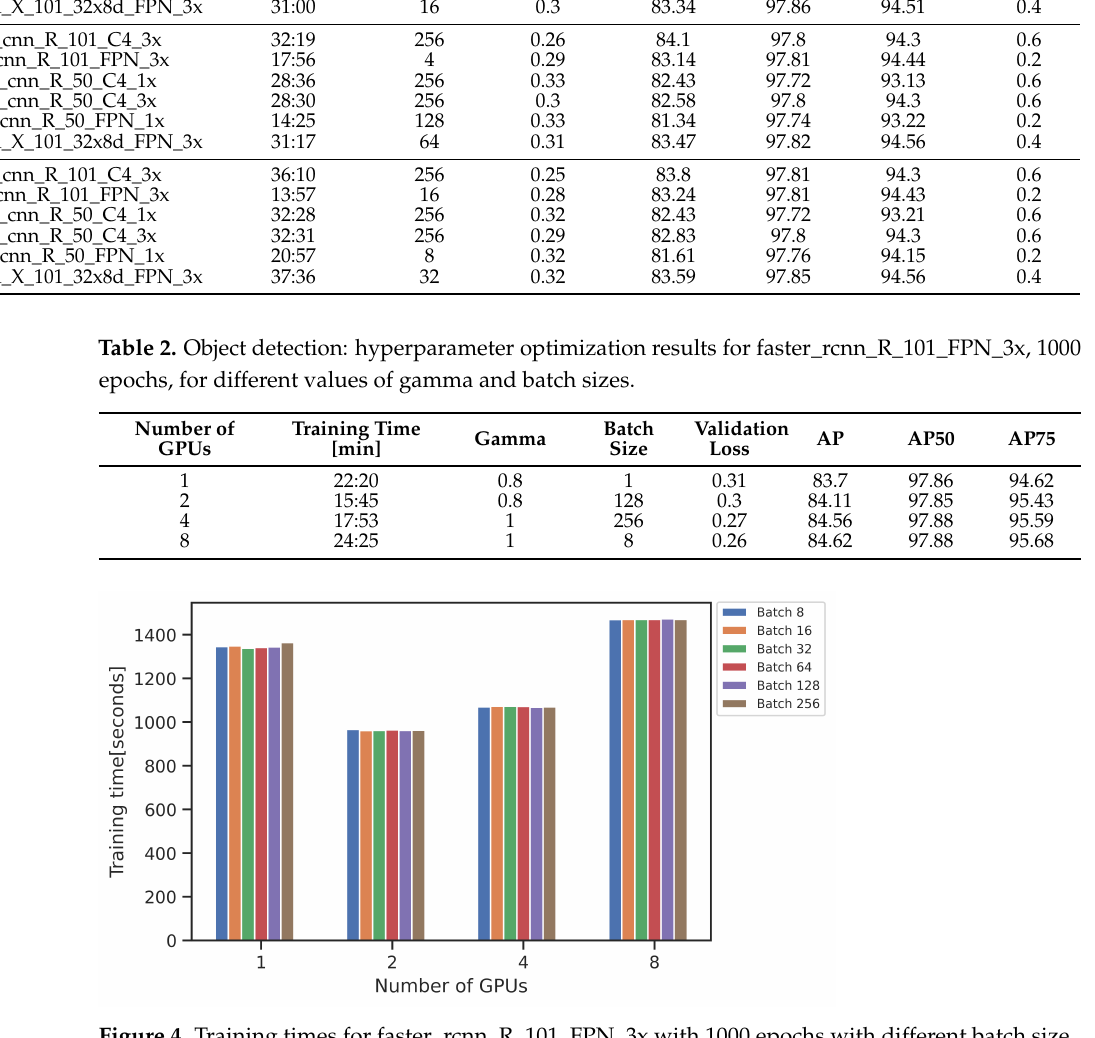
Figure 4. Training times for faster_rcnn_R_101_FPN_3x with 1000 epochs with different batch